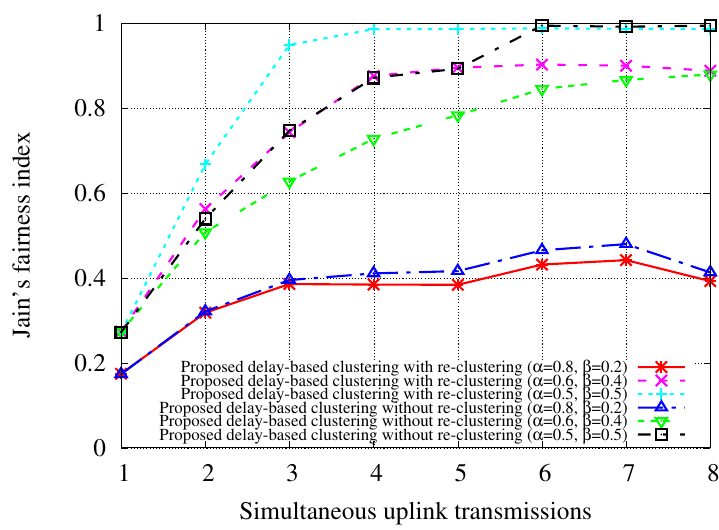
Figure 9. Fairness performance (MCS of 80% stations changes, λ = 1.5).